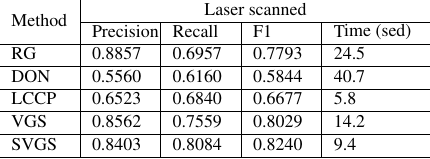
Table 1. Evaluation of segmentation results of the building facade dataset 5.3 Results of construction site